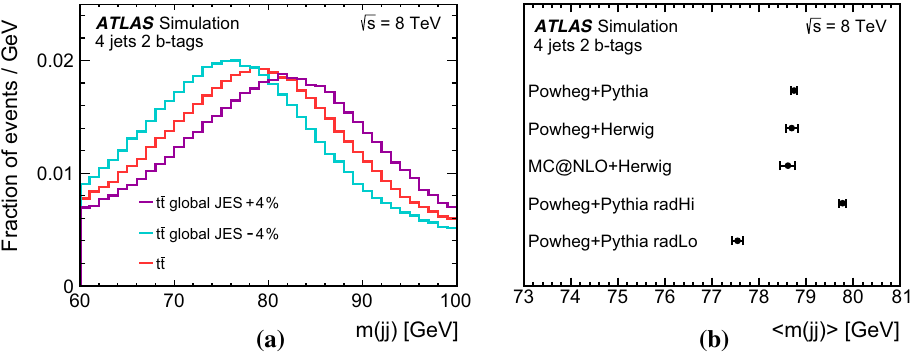
Fig. 4 a Probability densities of the m ( jj ) distribution from the t ¯ t sig- nal process for three different values of the JES, where events beyond the x -axis range are not shown and the range is restricted to show the